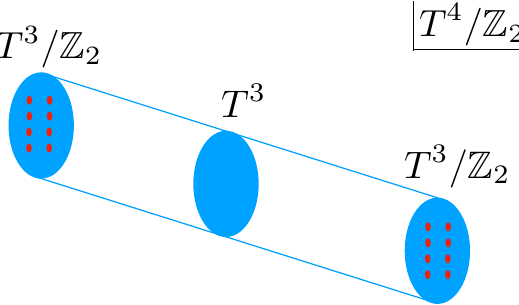
Figure 1 . The half-K3 limit of T 4 / Z 2 . The space degenerates into a long throat with cross section T 3 , while the 16 orbifold points, which correspond to the complicated geometry of the resolved space, recede to either end of the throat. If we put M-theory on this space, then the dual heterotic theory lives on the central T 3 and has gauge bundle determined by the distant